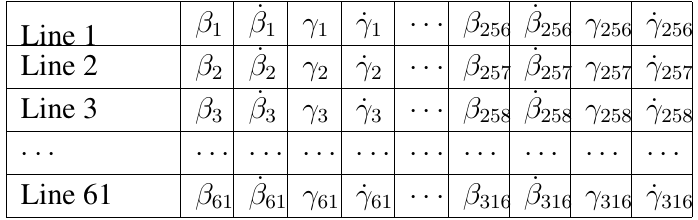
Table 2. Data Buffer of